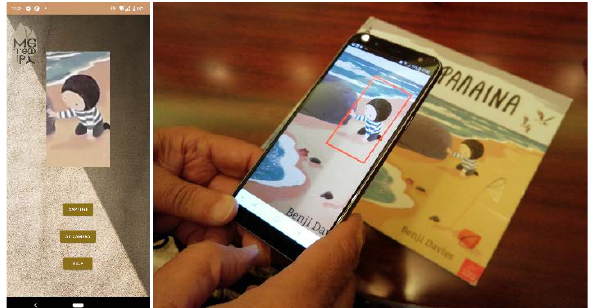
Figure 5 . Left: User interface, displaying the pattern image captured by the user; Right: Photograph showing the pattern recognition process by the